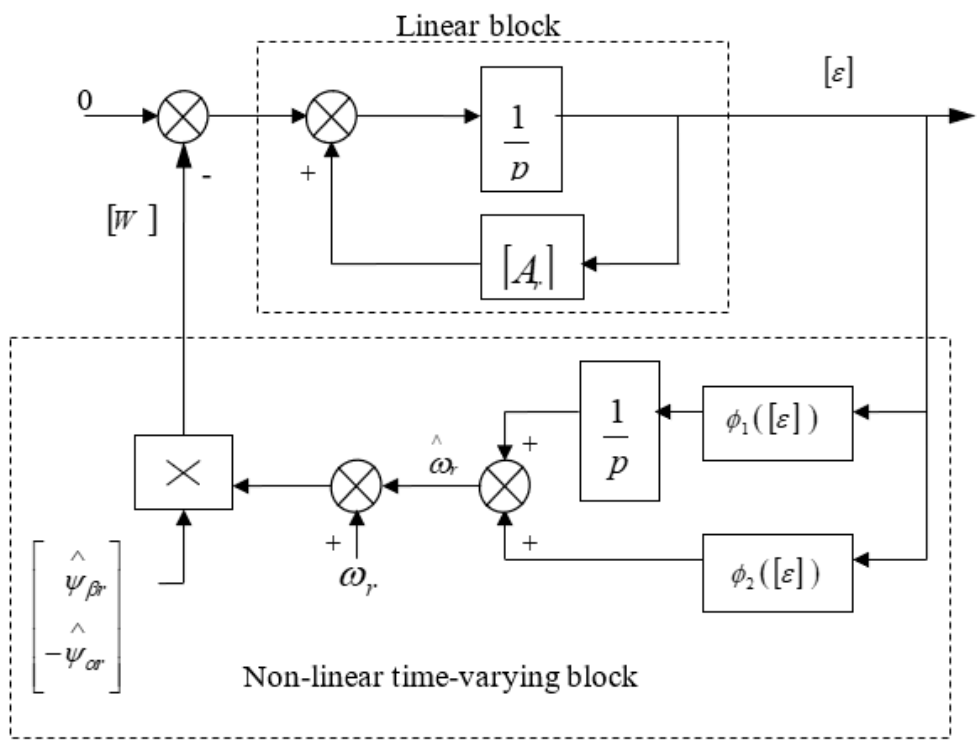
Figure 6. Representation of MRAS as a non-linear feedback system.